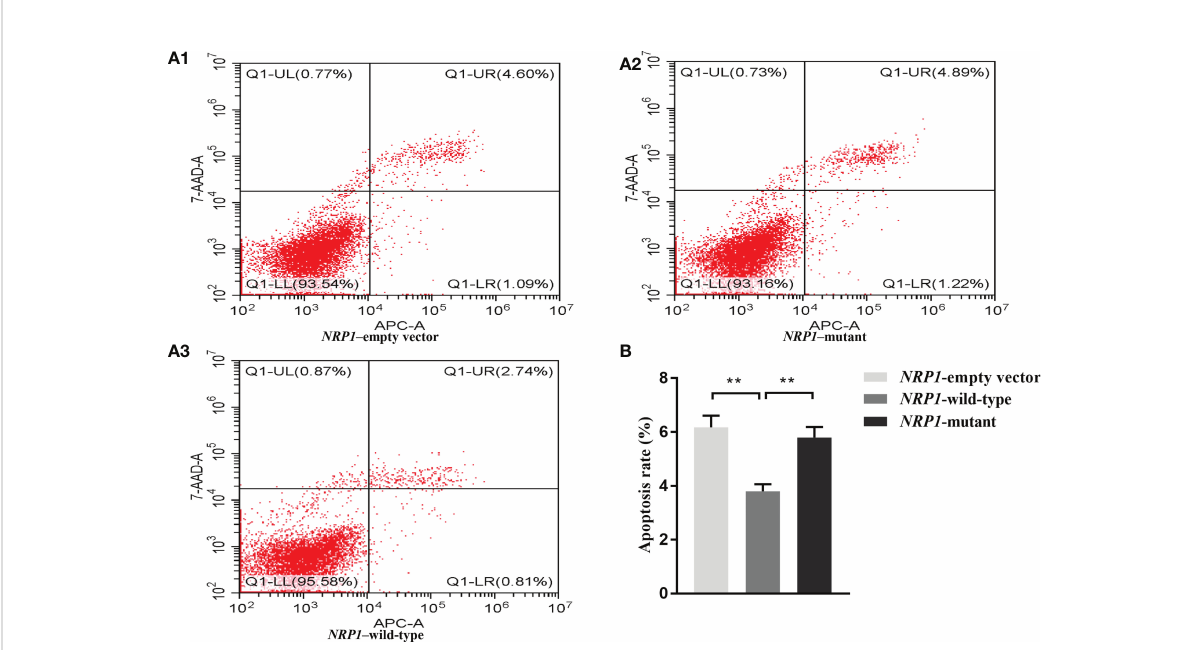
FIGURE 3 Cellular apoptosis comparisons among osteoblasts transfected with empty, and wild-type and mutant of NRP1 rs180868035 vectors. (A) fl ow cytometry. Representative APC-A-area versus 7-AAD-A-area density plots of different treatment groups with percentages of cells at different stage of apoptosis shown in the relevant quadrants. Q1-UR quadrant is positive for both APC-A and 7-AAD-A and represents cells in late apoptosis; Q1-LR is APC-A positive/7-AAD-A negative and represents cells in early apoptosis; Q1-LL is negative for both APC-A and 7-AAD-A and contains viable cells; Q1-UL is 7-AAD-A positive/APC-A negative and contains cells undergoing necrosis. (B) histogram of osteoblast apoptosis. ** indicated P <